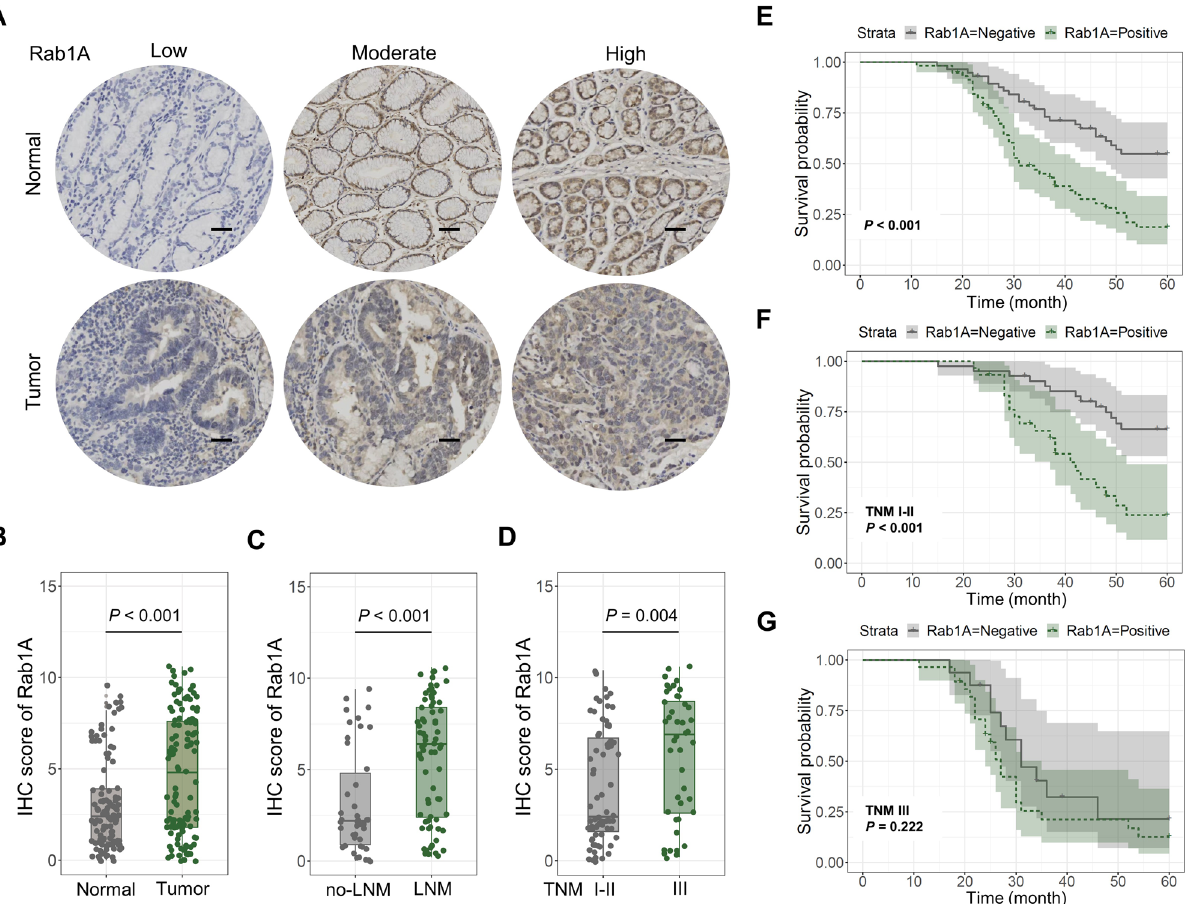
Figure 1. Rab1A expression and Kaplan–Meier analysis among 115 GC patients. ( A ) Rab1A expression using IHC staining in 115 GC and para-cancer tissues (scale bar 100um). ( B – D ) The IHC score of Rab1A in ( B ) GC and para-cancer tissues, ( C ) GC with or without lymph node metastasis, ( D ) GC with TNM I–II or TNM III staging. ( E – G ) Kaplan–Meier analysis of Rab1A positive vs. Rab1A negative in ( E ) 115 GC patients, ( F ) GC patients with TMN I–II staging, and ( G ) GC patients with TMN III